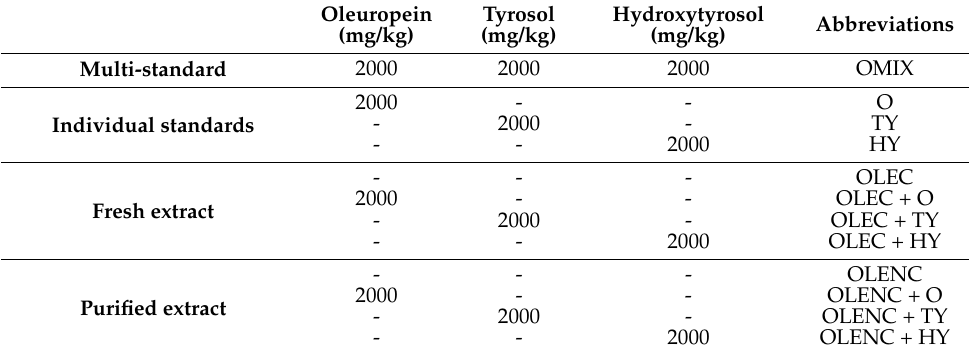
Table 2. Combinations of individual phenolic compounds with both fresh and purified